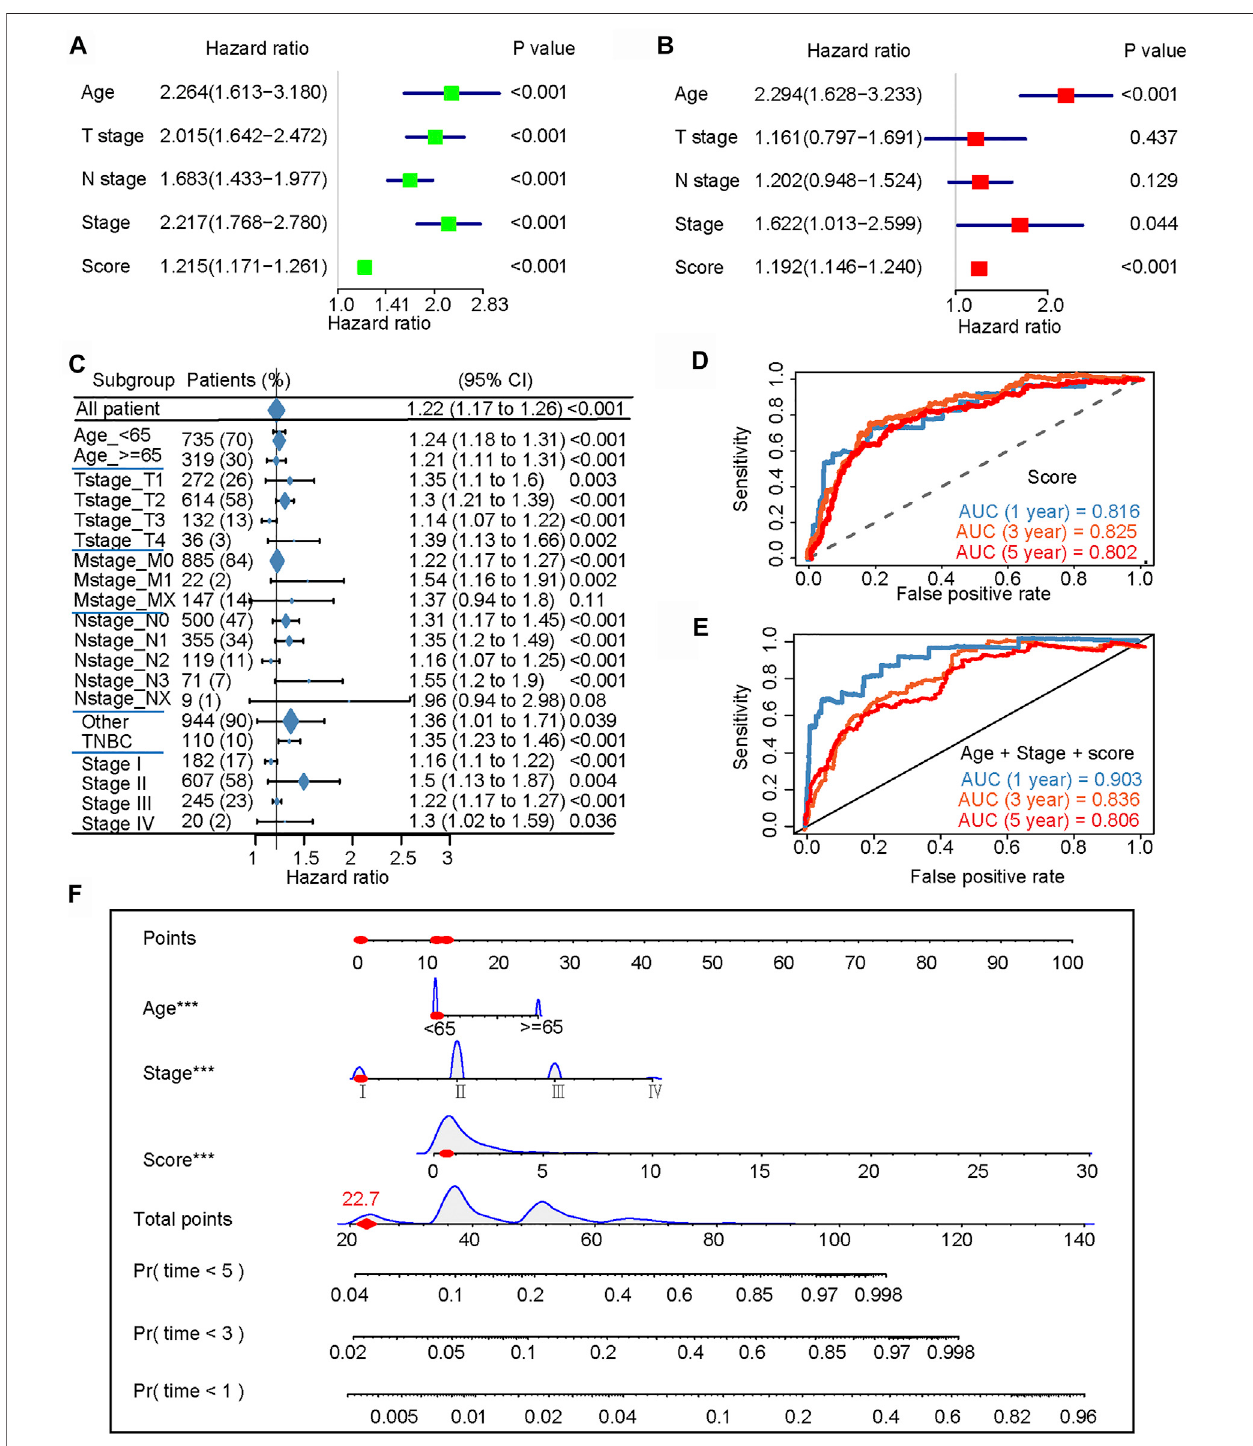
FIGURE 6 | N 6 -methyladenosine-related immune score (m6A-IS) is an independent prognostic factor for patients with breast cancer (BRCA). (A , B) Univariate and multivariate Cox analyses further showed that age, tumor stage, and m6A-IS are independent prognostic predictors for patients with BRCA. (C) Univariate Cox regressionanalysisoftheoverallprognosticvalueofm6A-ISineachclinicalfeaturesubgroup. (D) ROCcurveconstructedbasedonm6A-IS.TheAUCsoftheROCcurve at 1, 3, and 5 years were 0.816, 0.825, and 0.802, respectively. (E) The m6A-IS combines age and tumor stage to construct a fi nal predictive prognostic model. The results showed that the multi-predictor ROC has excellent accuracy for 1-, 3-, and 5-year overall survival (OS) (AUC (cid:1) 0.903, 0.836, and 0.806, respectively). (F) Nomogram based on m6A-IS, age, and stage in The Cancer Genome Atlas (TCGA) cohort.